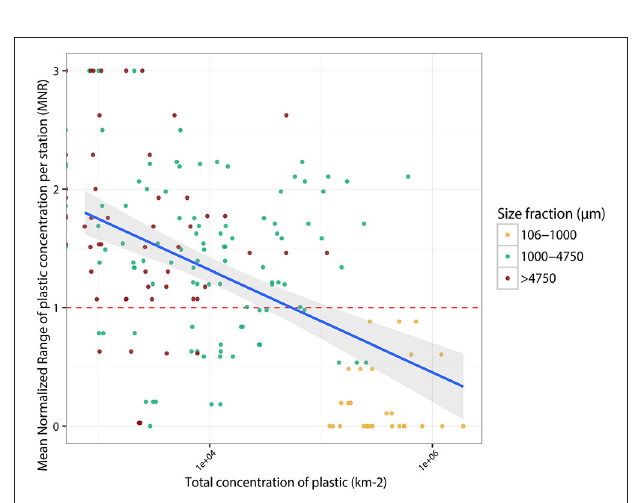
FIGURE 5 | Plot of trawl mean normalized ranges (MNR) across stations vs. the log of plastic concentration in each individual trawl. Regression line of the linear model used to predict MNR from plastic concentration is shown ( R 2 = 0.442, slope = − 0.357, intercept = 2.737, p < 2.2e-16). The gray band depicts the 95% confidence level interval for predictions from the linear